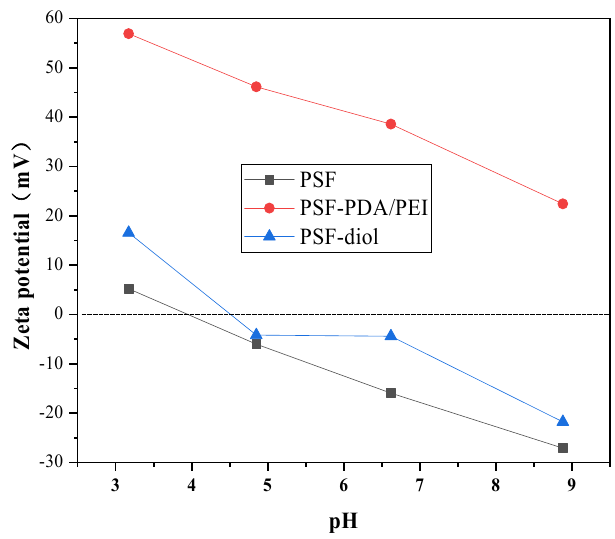
Figure 7. The zeta potential for PSF-PDA/PEI and PSF-diol membranes in different pH.